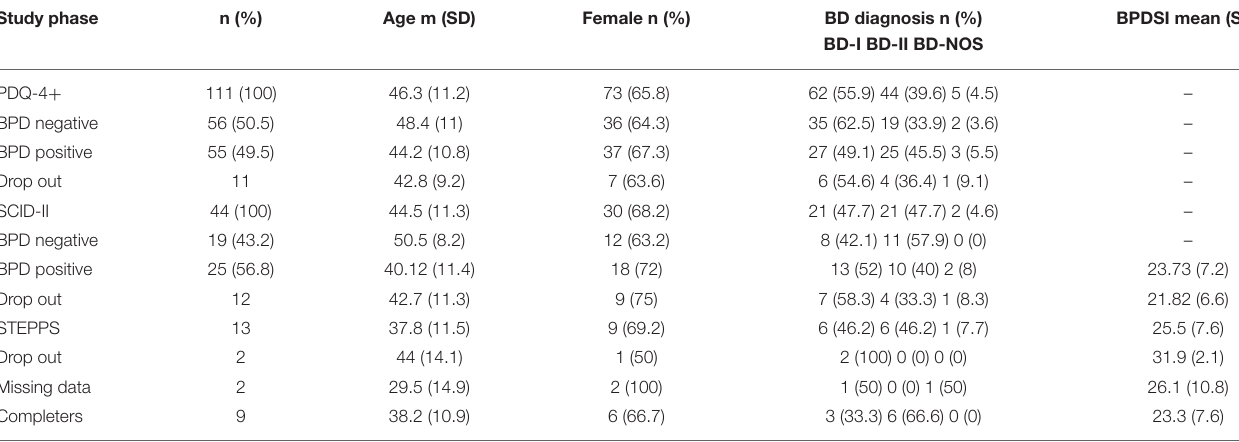
TABLE 1 | Demographic and clinical characteristics of patients with bipolar disorder in various phases of the study. Study